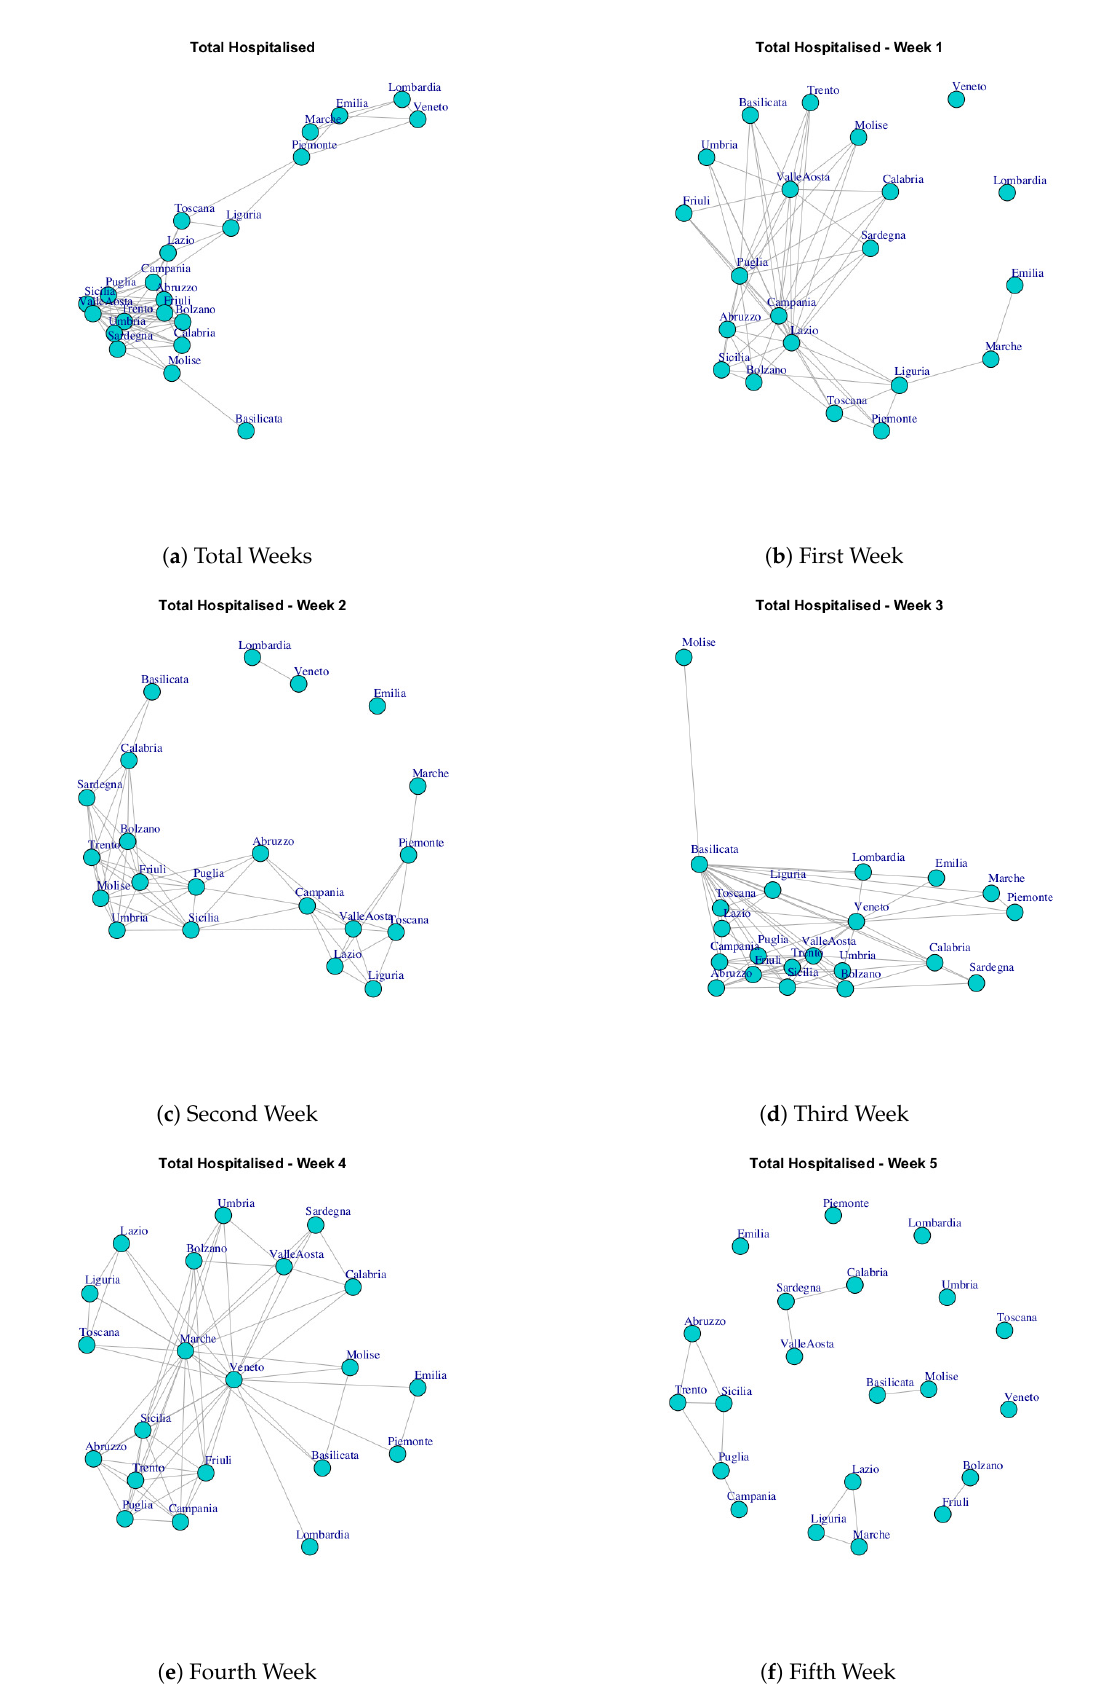
Figure 5. Evolution of Total Hospitalized